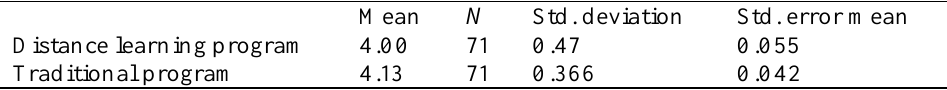
The Mean Evaluation Scores Received from Students Participating in the Online Distance Learning Program and the Traditional Classroom Program Mean N Std. deviation Std. error mean Distance learning program 4.00 71 0.47 0.055 Traditional program